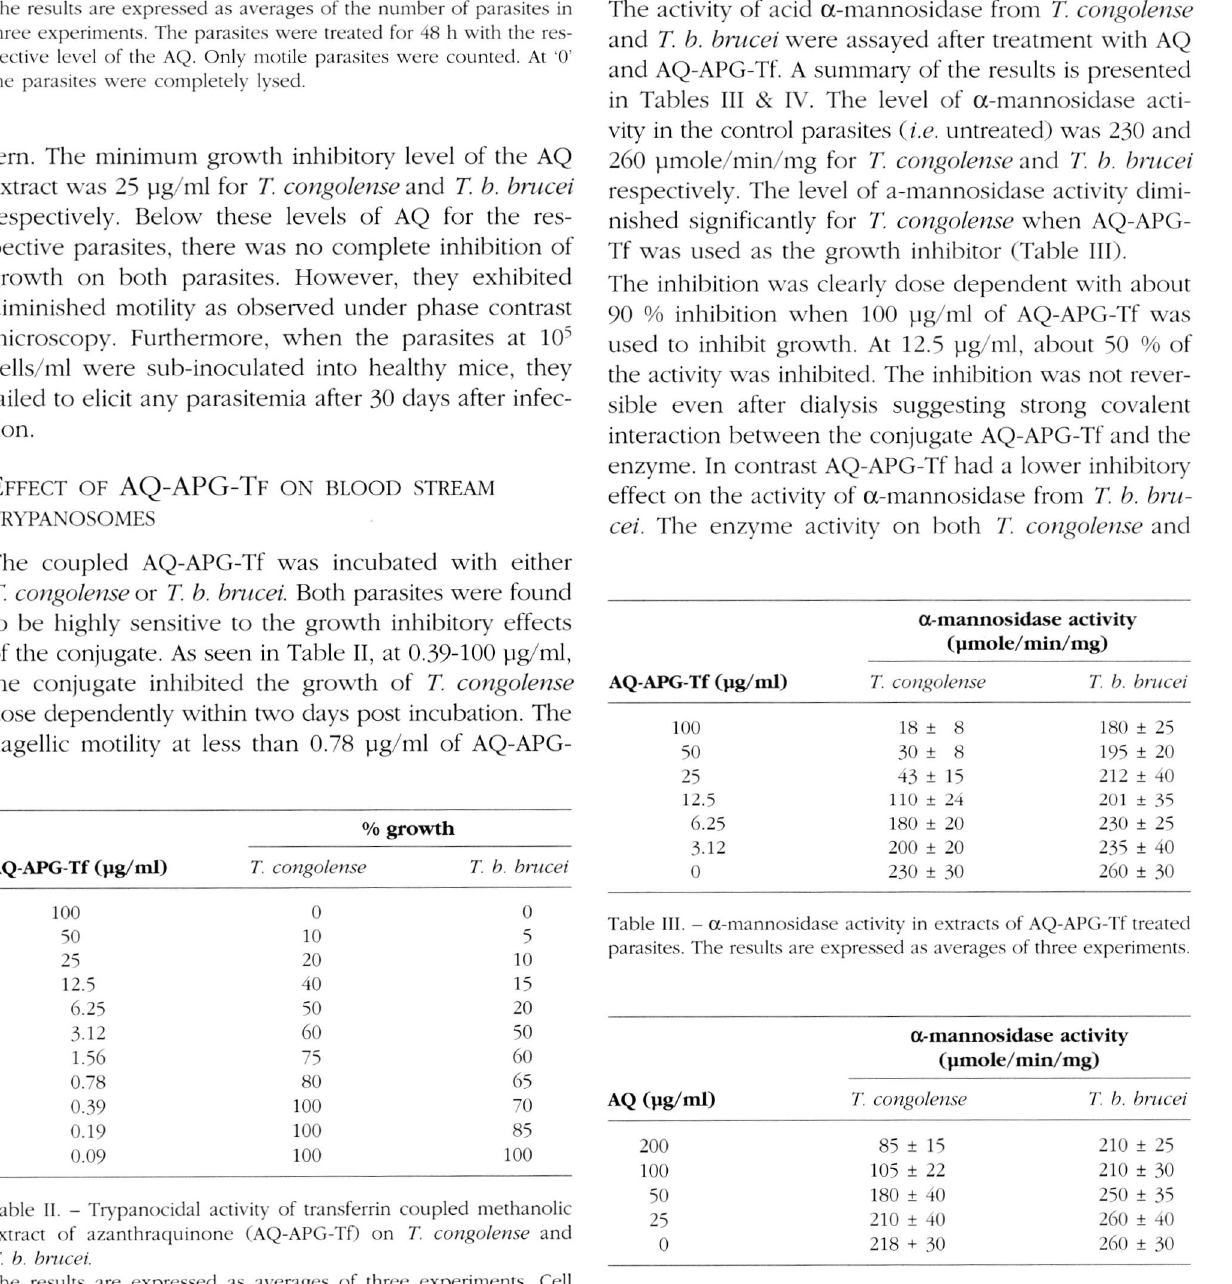
Table II. - Trypanocidal activity of transferrin coupled methanolic extract of azanthraquinone (AQ-APG-Tf) on T. congolense and 7'. b. bnicei.